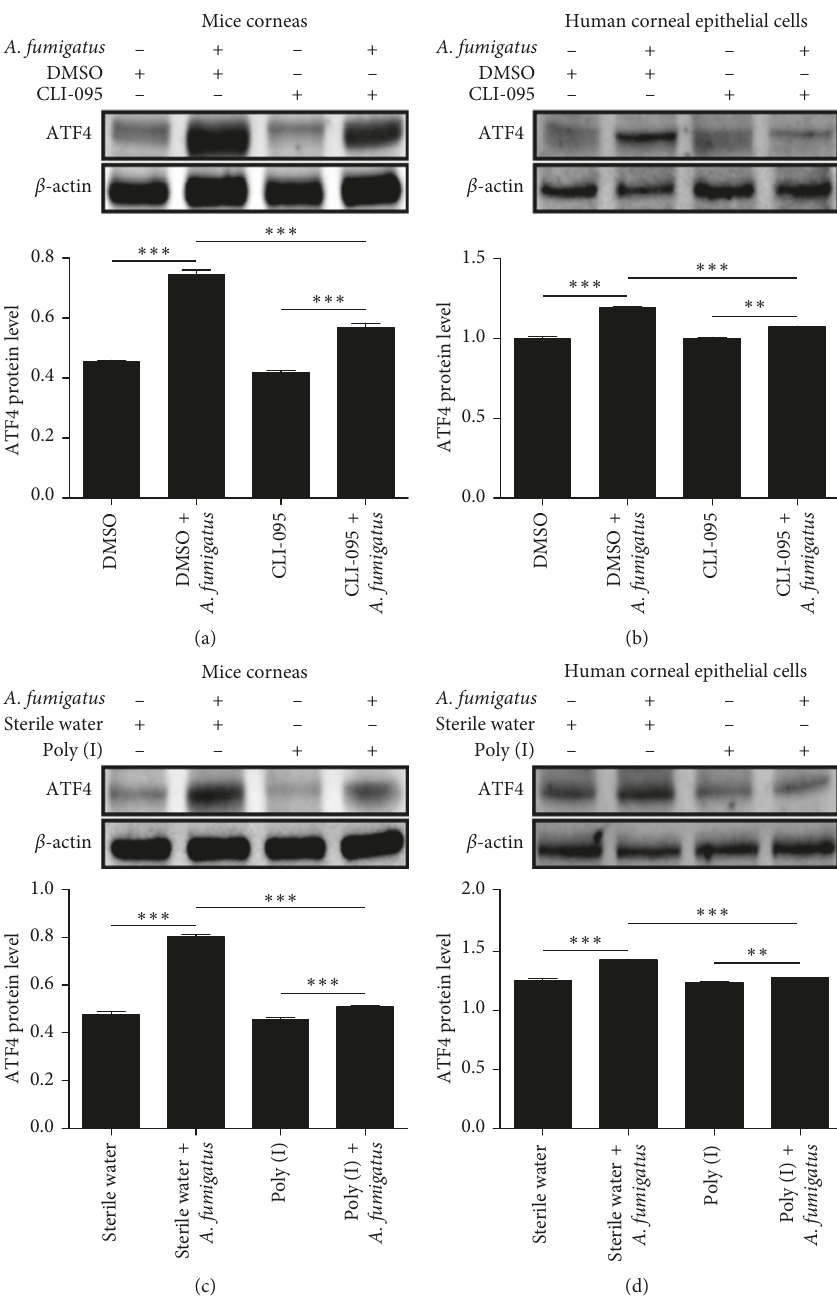
Figure 4: ATF4 expression in response to A. fumigatus infection was dependent on TLR4 and LOX-1. With pretreatment using a TLR4 inhibitor, ATF4 protein levels in infected mouse corneas (a) at 1 day after infection and HCECs (b) at 16 hours after A. fumigatus infection were significantly lower. ATF4 protein levels in infected mouse corneas (c) and HCECs (d) were significantly lower with the pretreatment of LOX-1 inhibitor. The mean values and standard deviations of two independent experiments are shown; ∗∗ P < 0 . 01, ∗∗∗ P < 0 .